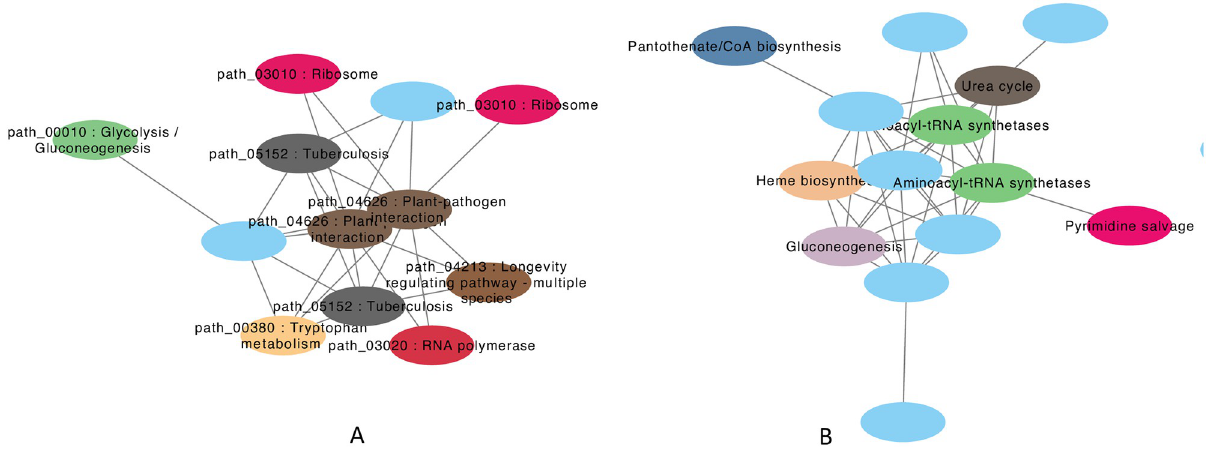
Fig 4. Example protein co-abundant modules extracted from specialists. (a) Limosilactobacillus mucosae a specialist found in CD samples ( L. mucosae was one of the two most highly expressed specialists discussed in this paper), and (b) Escherichia flexneri a specialist found in acute leukemia patients. The nodes are proteins: unknown proteins are in blue, and they are connected to proteins with functional annotations (shown in other colors) through our co-occurrence